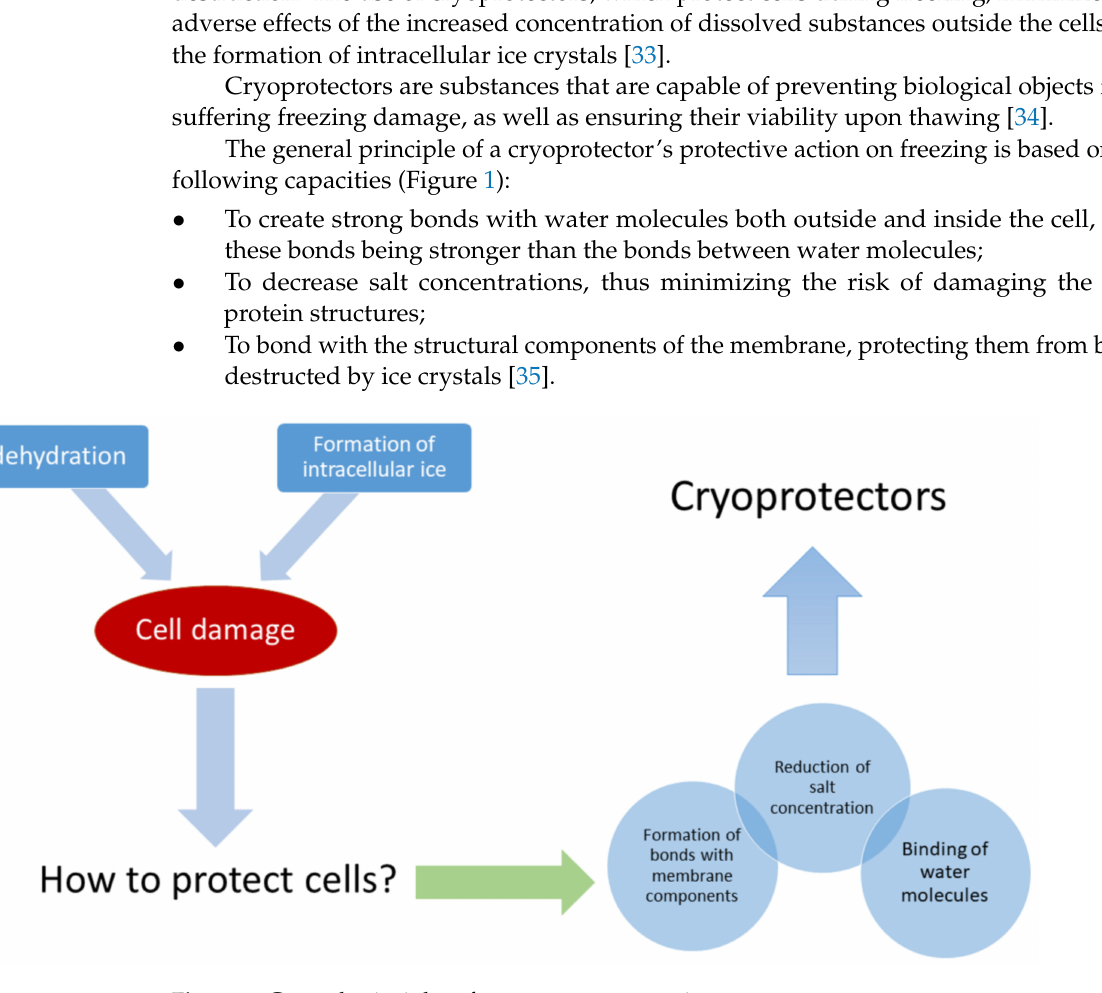
Figure 1. General principles of cryoprotector